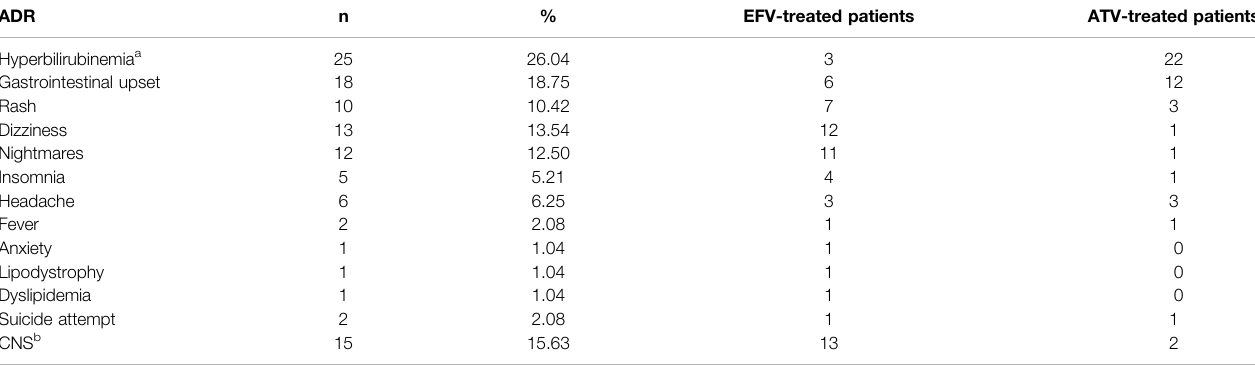
TABLE 2 | Type of adverse drugs reactions in patients undergoing antiretroviral therapy with EFV or ATV. ADR n %